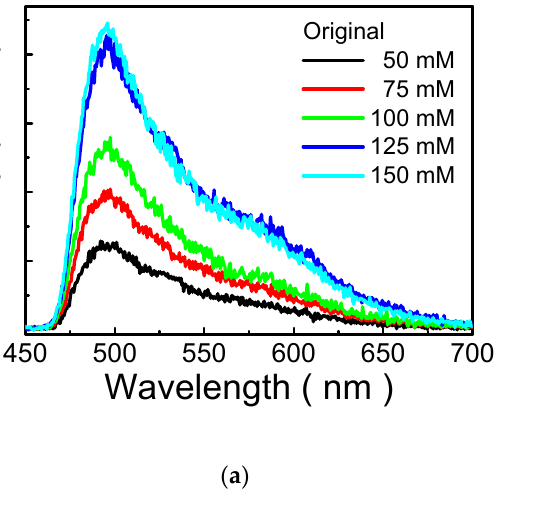
Figure 5. ( a ) PL spectra (original) of MP1D films coated from different solutions (50, 75, 100, 125, and 150 mM); ( b ) PL spectra (normalized to film thickness) of MP1D films coated from 50, 75, 100, 125, and 150 mM solutions.